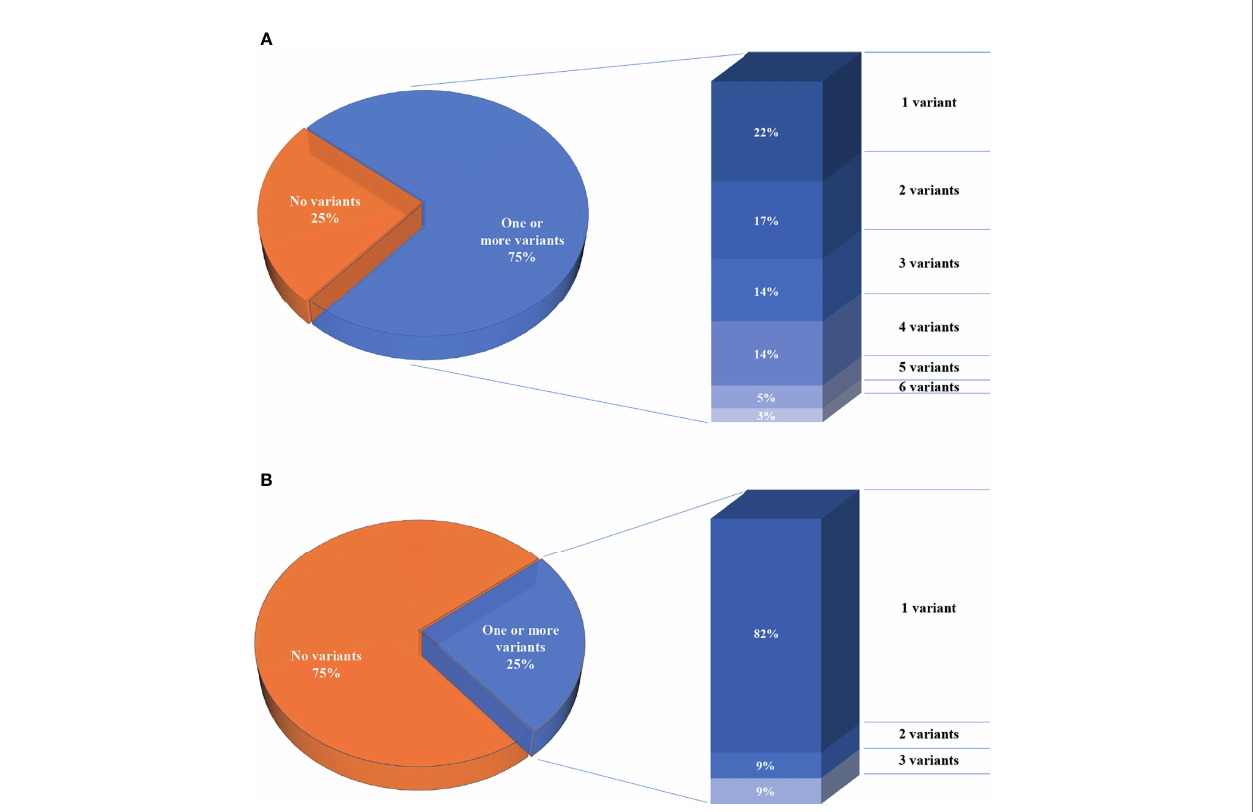
FIGURE 2 | Percentages of the number of patients per number of variants. (A) Seventy- fi ve percent of patients analyzed through the OVO-Array panel harbor one or more variants, left. Histogram representing the percentages of patients carrying variants, right. (B) Twenty- fi ve percent of patients analyzed in only nine known POI